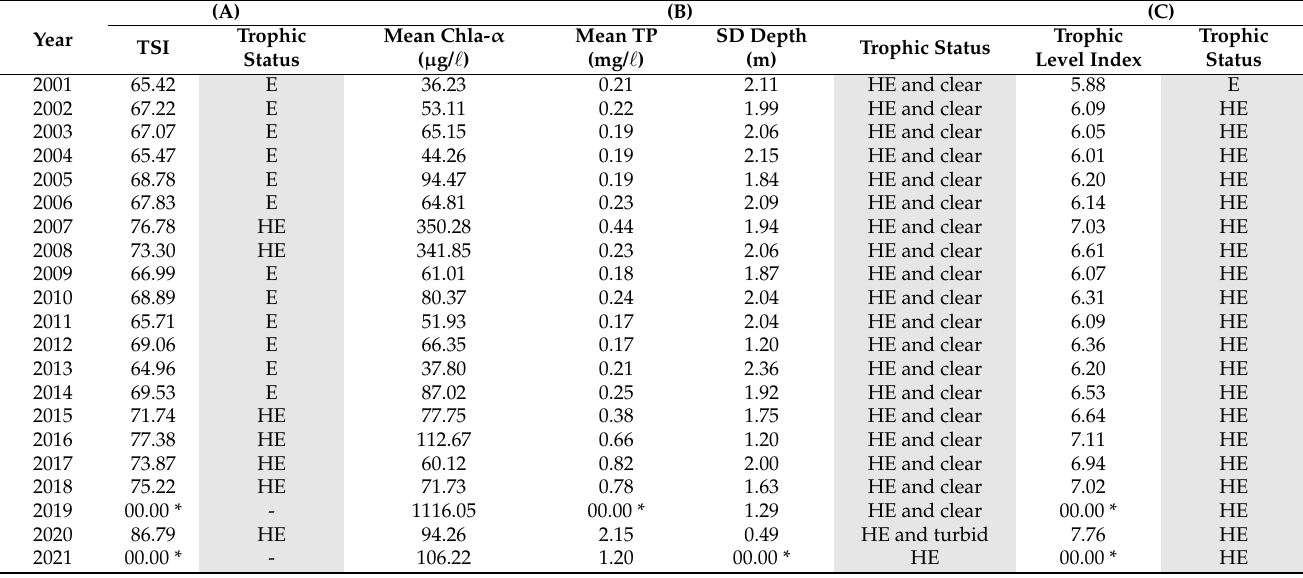
Table 5. Results of trophic state classified as per (A) the Carlson method, (B) the van Ginkel method, and (C) Burns et al.’s Trophic Level